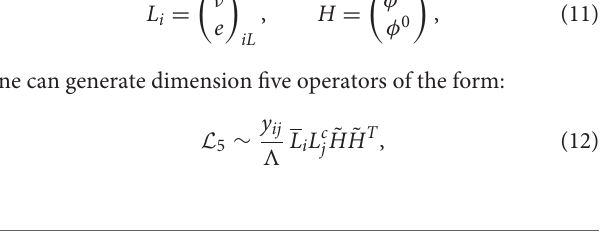
TABLE 1 | Value of the oscillation parameters obtained from a global analysis from Esteban et al. [20].